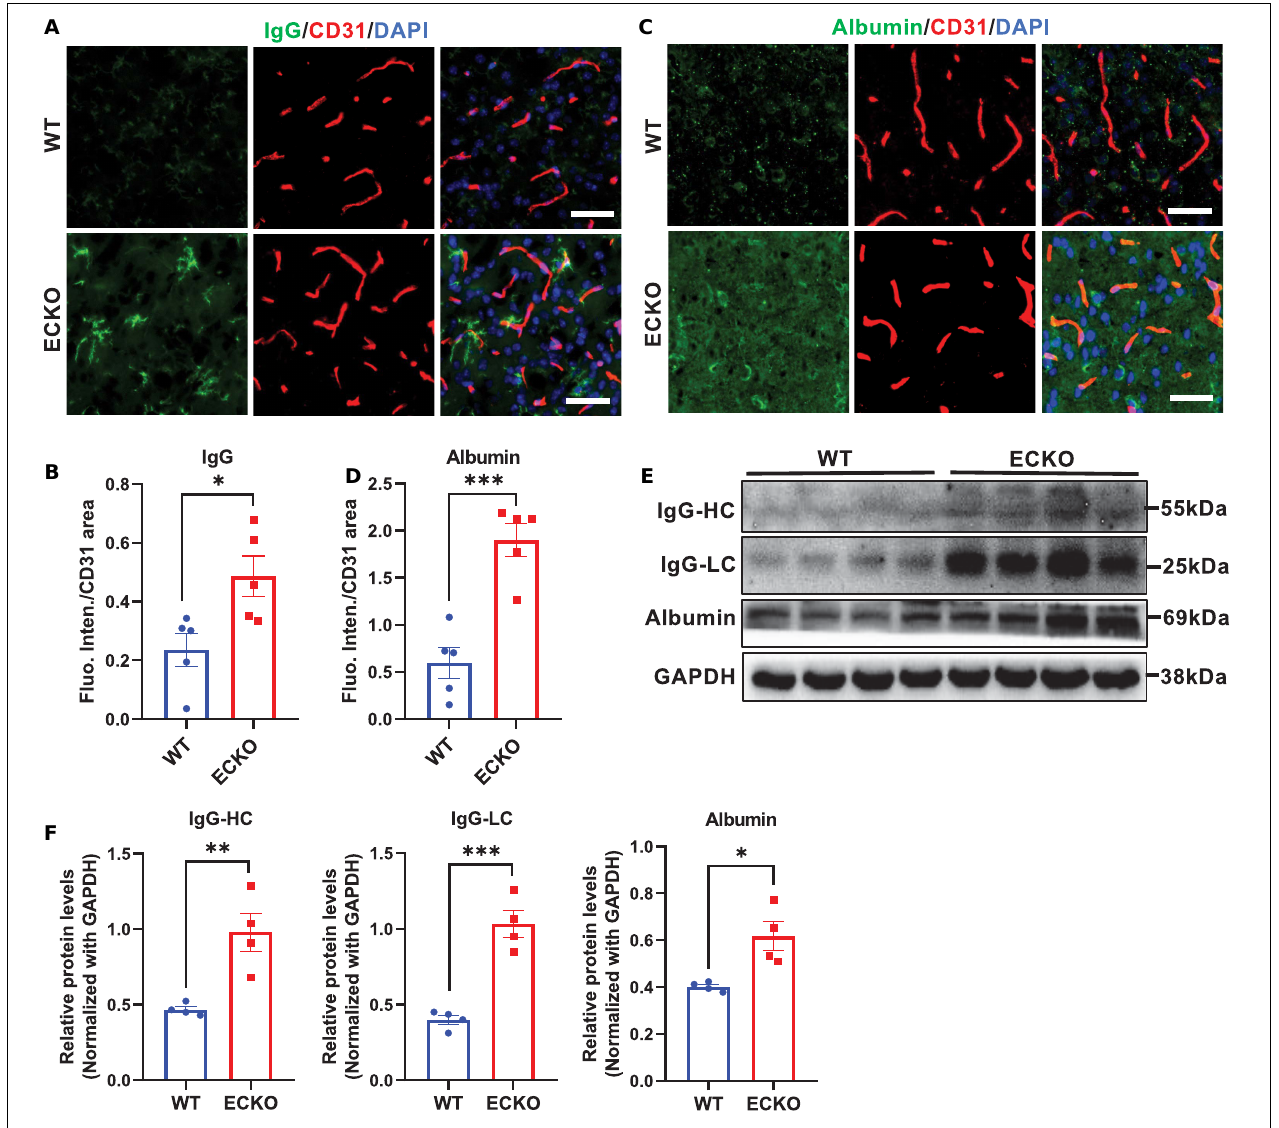
FIGURE 2 | Endothelial cell-specific deletion of β -catenin increases BBB permeability in adult mice. (A,C) Immunofluorescence staining showing leakages of blood IgG (A) or albumin (C) in the cerebral cortex from β -cat WT mice and β -cat ECKO mice, respectively. Scale bars, 100 µ m. (B,D) Quantifications of the fluorescence intensity of IgG (B) and albumin (D) normalized with CD31 area, respectively. (E) Protein levels of IgG and albumin in the cerebral cortex from β -cat WT mice and β -cat ECKO mice. (F) Quantification of the IgG and albumin protein levels normalized with that of GAPDH. Data are mean ± SD. n = 4–5 mice per group. Significance of data is represented as: ∗ P < 0.05, ∗∗ P < 0.01, ∗∗∗ P <